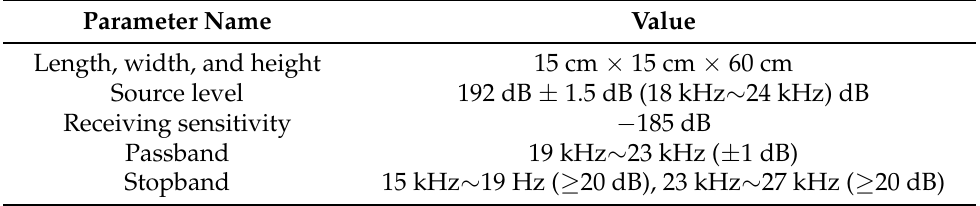
Figure 9. The original picture of experimental work performed. Table 4. Parameters of transceiver.